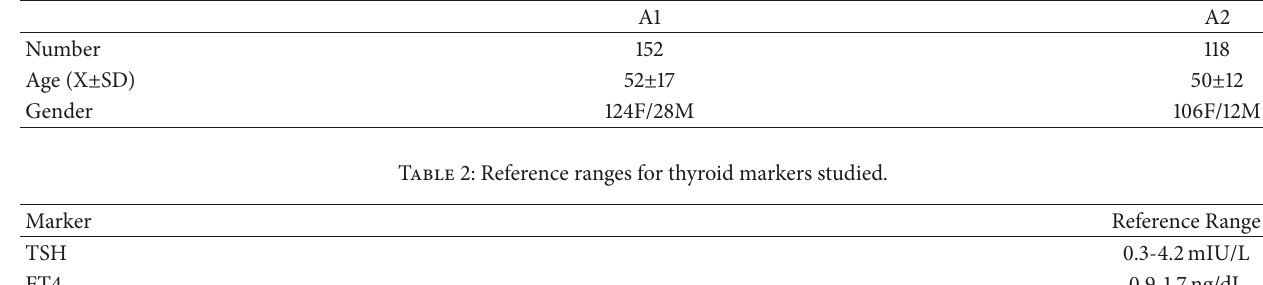
Table 1: Demographics of the subjects studied.